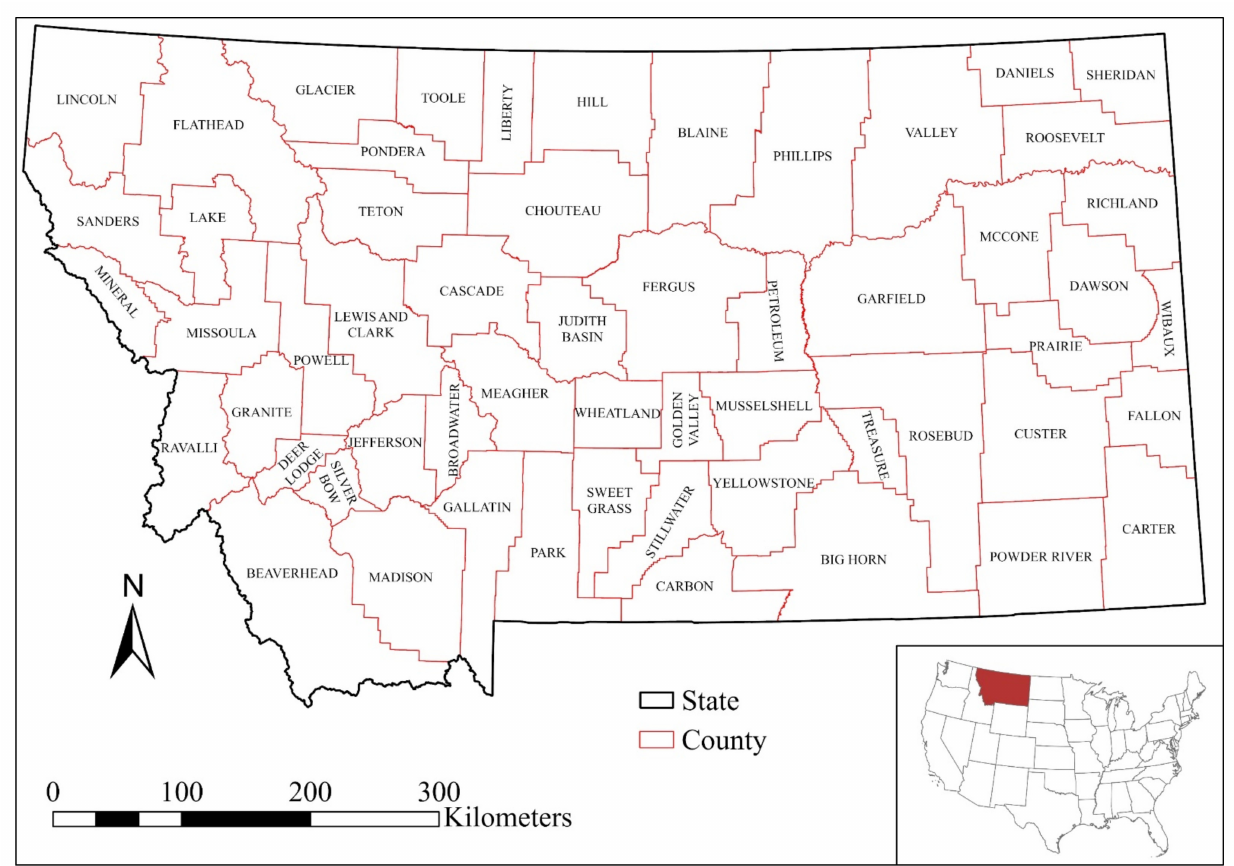
Figure 1. The map of the study